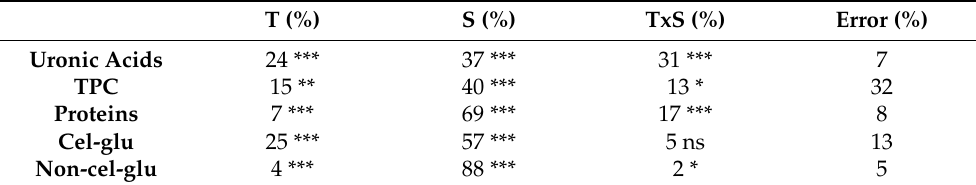
Table 3. Multivariable factorial analysis of cell wall components with treatment, season and treatment– season